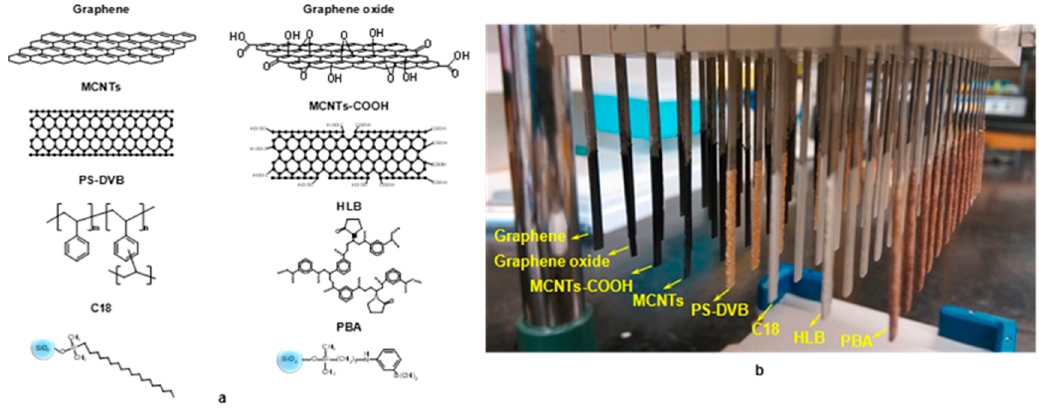
Figure 3. ( a ) Structural scheme of eight di ff erent types of adsorbents and ( b ) photograph of thin-film coatings prepared from eight di ff erent